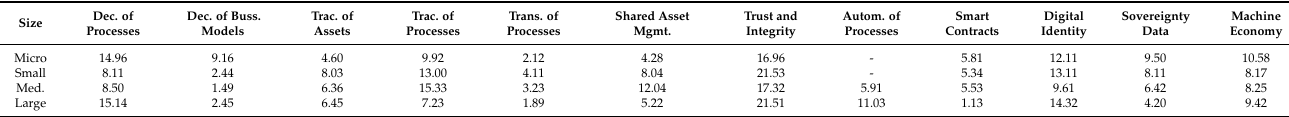
Table 2. Applications investment by company size (percentages).